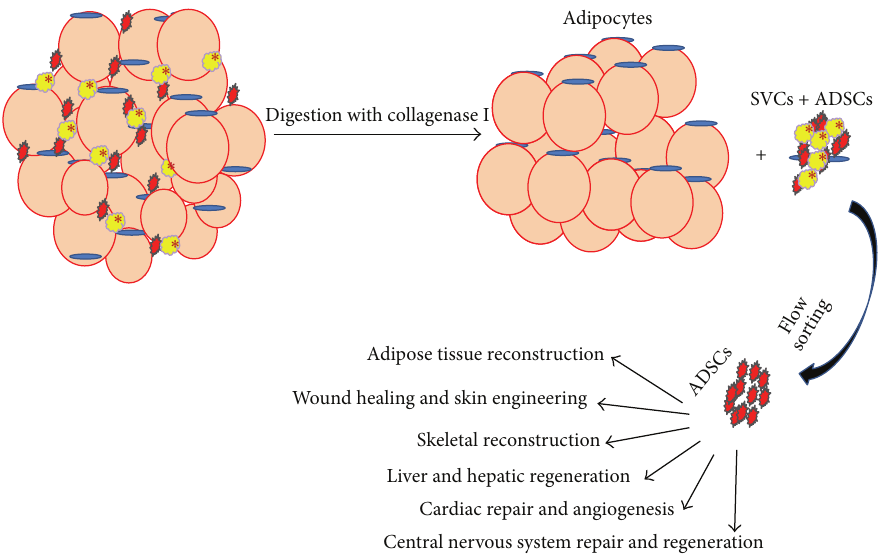
Figure 1: Schematic diagram for ADSCs isolation from adipose tissue and several uses of ADSCs in tissue regenerative medicine.